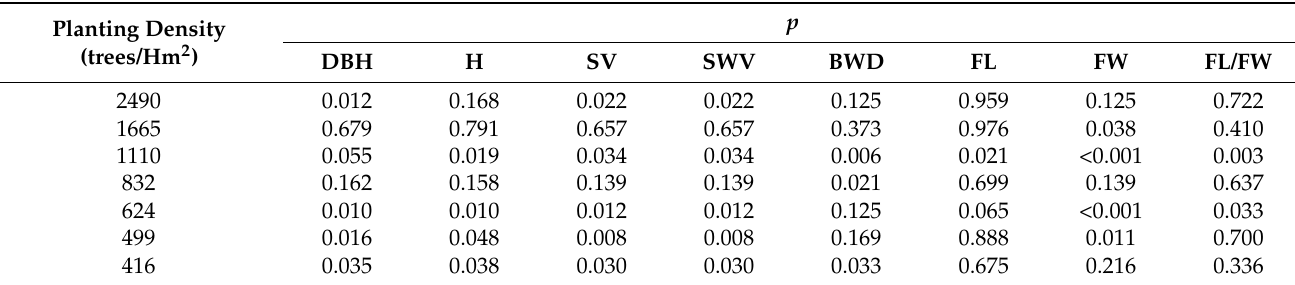
Table 4. Analysis of variance results for tree growth and wood properties of 11-year-old triploid Chinese white poplar plantation within each initial planting density.